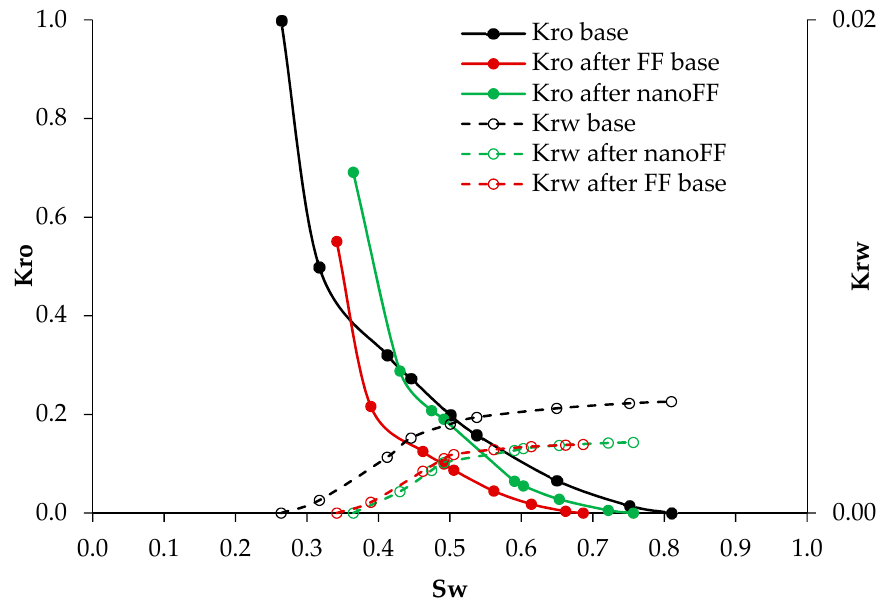
Figure 14. Relative permeability curves before and after injection of the original and optimized NanoFF were conducted in the Castilla oil field porous media.